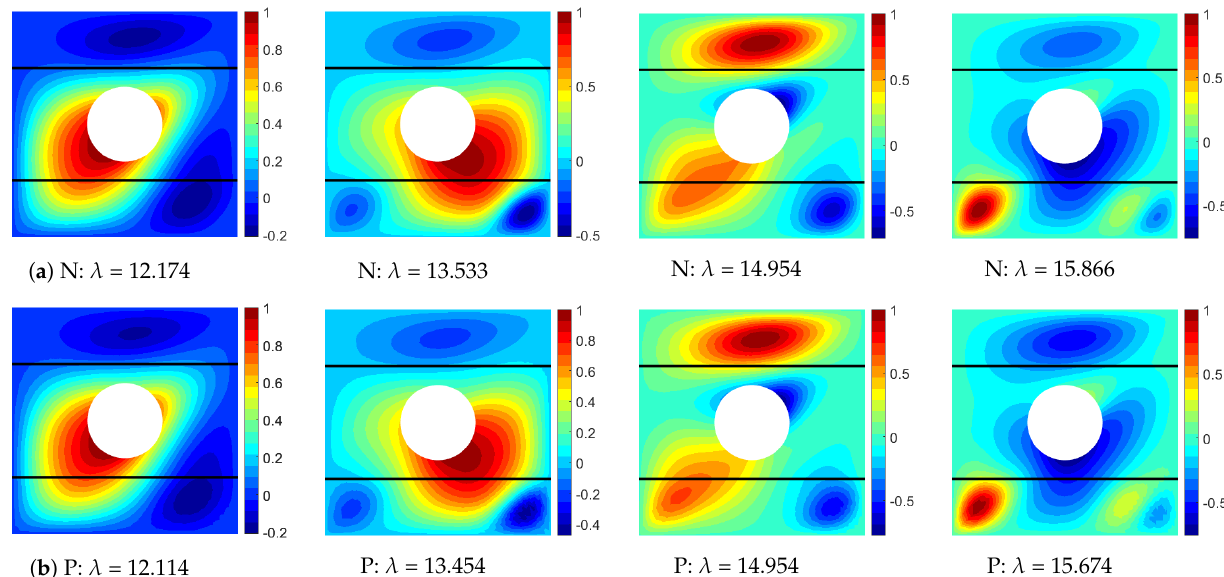
Figure 19. Comparison of buckling eigenvalue ( λ ) and buckling mode shapes of the stiffened plate under pure in-plane bending displacements. ( a ) N: NASTRAN results; ( b ) P: Present